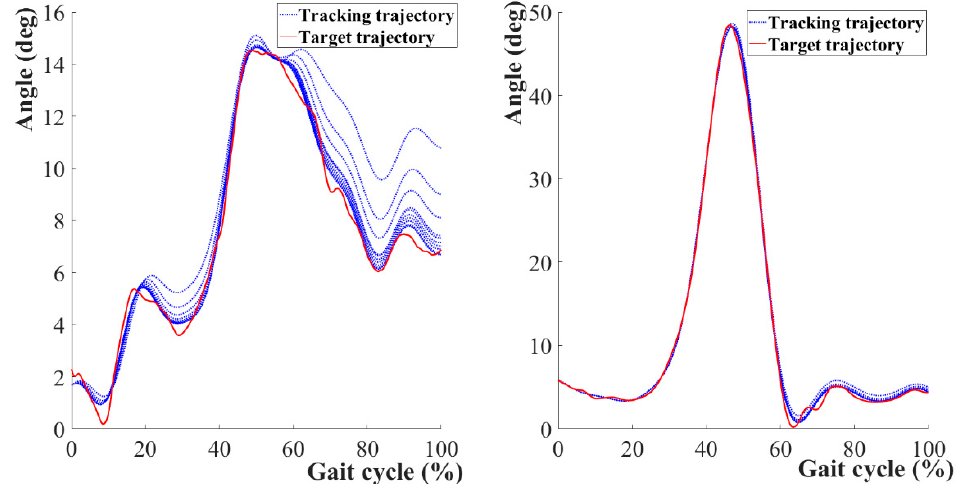
Figure 7. Gait angle tracking results of the hip (left) and knee (right) joint over 10 iterations.